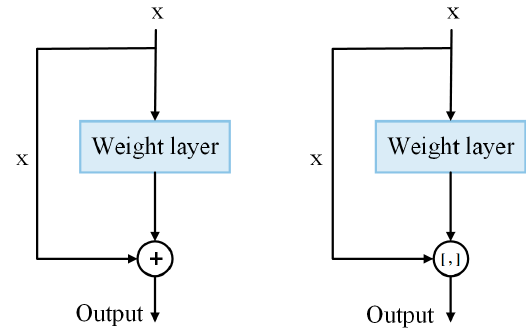
Figure 3. Two methods of combining feature maps.